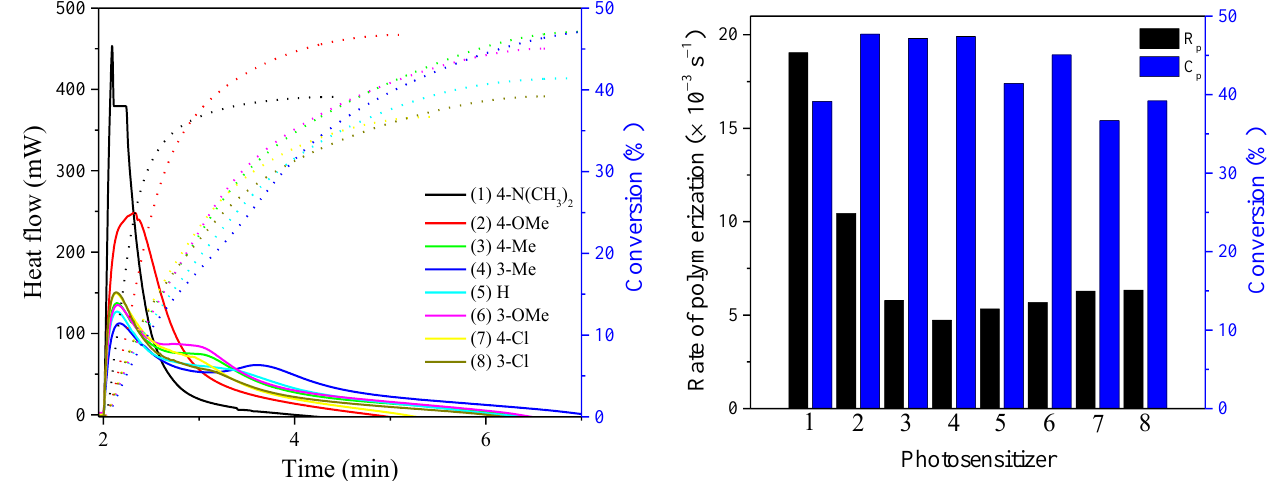
Figure 22. Kinetic profiles recorded during radical polymerization of trimethylolpropane triacrylate (TMPTA) initiated by two-component photoinitiating systems consisting of BODIPY dye as sensi- tizer (marked on the figure) in the presence of 1-methoxy-4-phenylpyridinium tetrafluoroborate (NO). The experimental conditions: concentration of PI—1 × 10 − 3 M/1 × 10 − 2 M (sensitizer/co- initiator); light intensity—50 mW × cm − 2 (solid line denotes data of heat flow during polymerization; dash line refers to monomer conversion). Reproduced from ref. [115], which was published under a CC BY license.